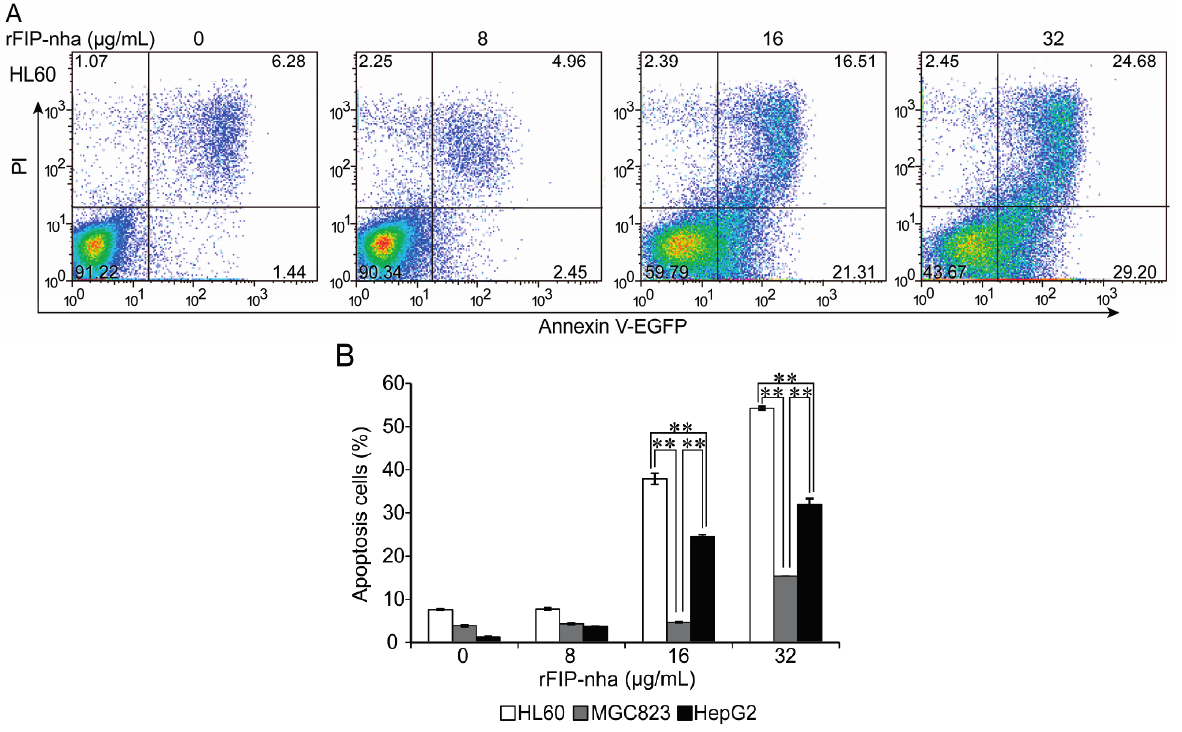
Figure 4. Apoptotic effects of rFIP-nha on human tumor cells. ( A ) RFIP-nha (8, 16, or 32 µg/mL) was incubated with HL60 cells for 24 h. Apoptotic induction was determined by fl ow cytometric analysis of Annexin V-EGFP and PI-staining. The upper right quadrant (UR) represented late apoptotic cells stained with Annexin V-EGFP and PI, and the lower right quadrant (LR) represented early apoptotic cells stained with Annexin V-EGFP; ( B ) Phase percentages for UR quadrant and LR quadrant are depicted on bar graph. Each bar represents mean ± SD ( n = 3). **: p <